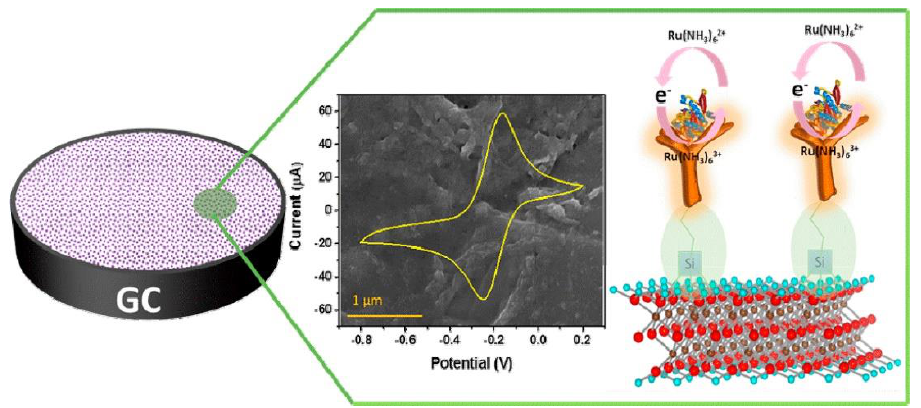
Figure 6. Schematic of the electrochemical carcinoembryonic antigen (CEA) detection mechanism (reproduced with permission from reference [62]).